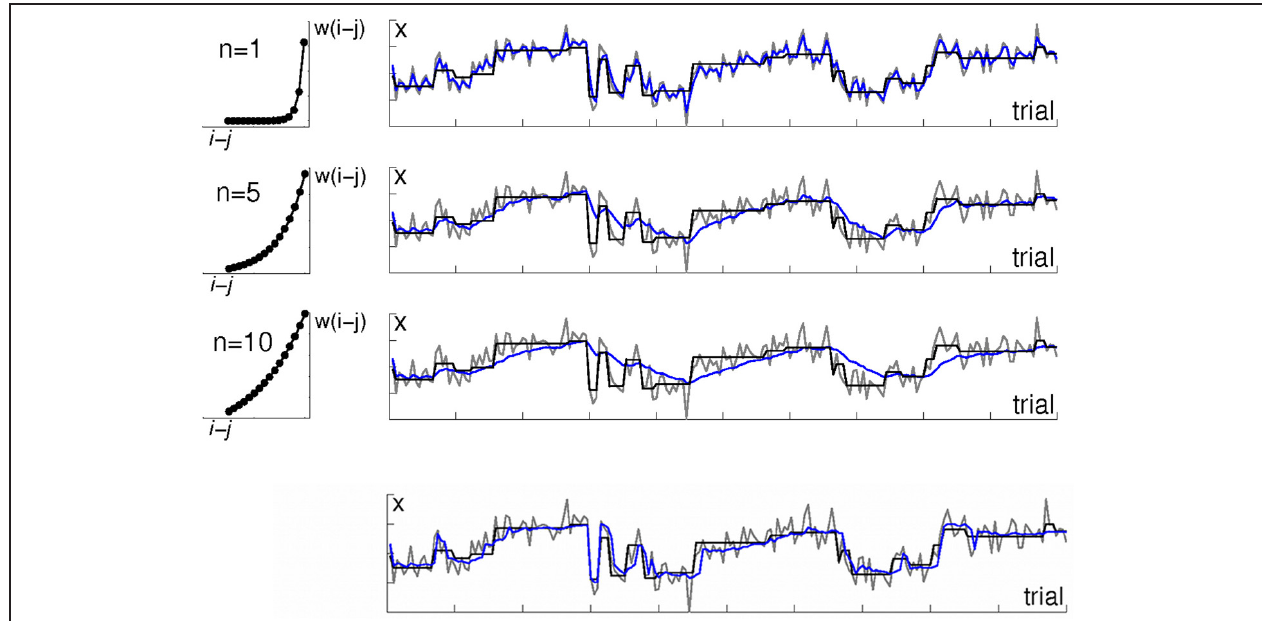
FIGURE 1 | Algorithms with a fixed temporal discount do not fit well to environments with a variable rate of change. The right-hand panels illustrate an environment in which observations are drawn from a Gaussian distribution; each row shows a different learning algorithm’s estimate of the distribution mean μ . The mean μ , which has period of stability interspersed with sudden change, is shown in black. Actual observations x are shown in gray. Estimates of μ are shown in blue. The top three rows are kernel-based learning algorithms with different time constants. The left hand panels illustrate the three weighting functions (kernels) which were used to determine the weighting of observations in the panels next to them. The weighting w( j ) assigned to observation i − j when calculating the mean μ ( i ) on observation i is defined by the exponential function w( i ) = exp( − j/n ). The rate of decay is